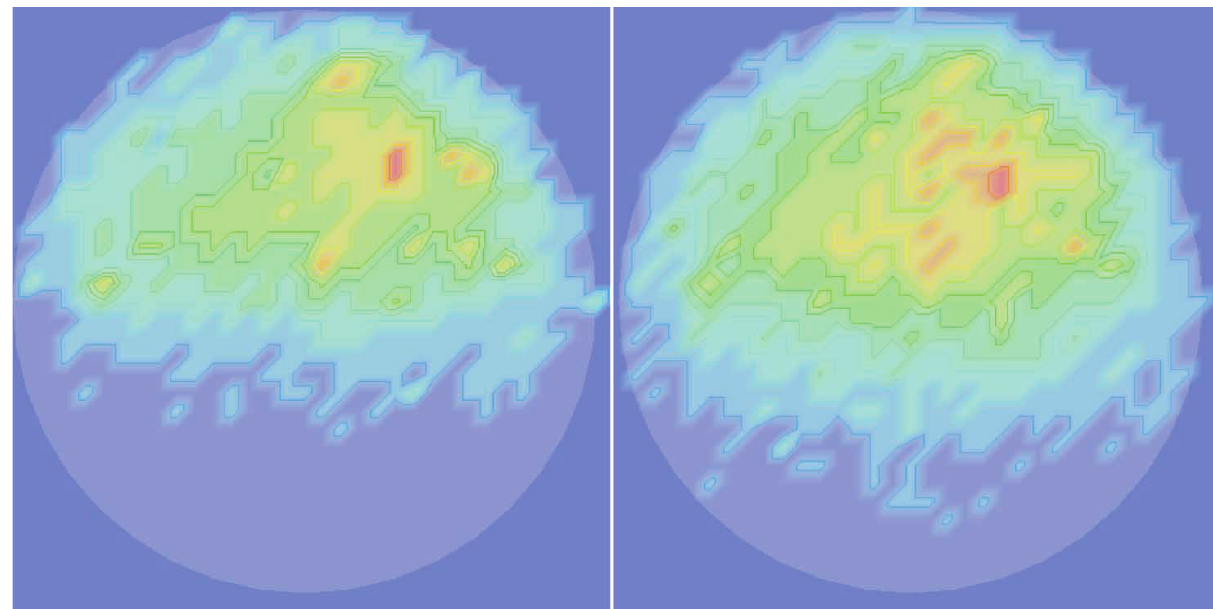
FIGURE 3 Differentiation signal concentration: the signal concentration is shown on the same section as in Fig. 2 (3D). At day 4 the differentiation signal has still low concentration and is limited in diffusion by the signal consuming centroblasts in the dark zone. At day 8 the differentiation already penetrates the dark zone and starts to destroy it by inducing centroblast differentiation. The signal concentration increases from blue to red.